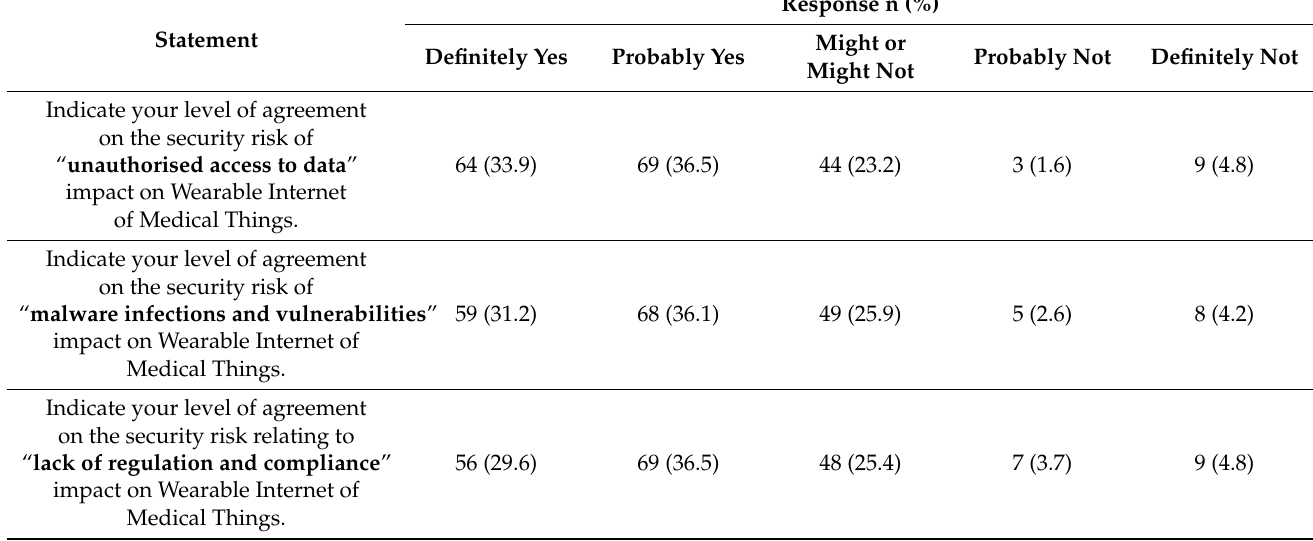
Table 4. Security risks of